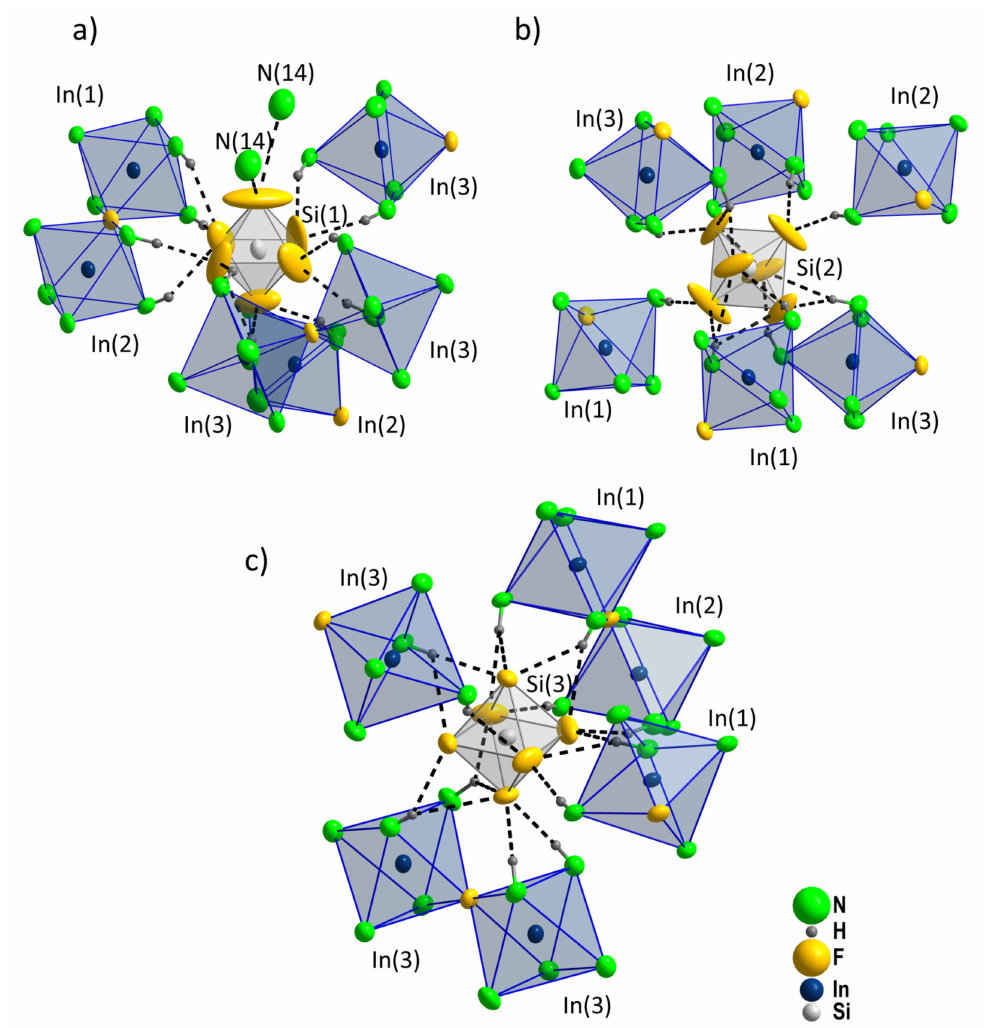
Figure 10. Interconnection of [SiF 6 ] 2 − octahedra to [(NH 3 ) 5 In − F − In(NH 3 ) 5 ] 5+ octahedra doubles via hydrogen bonds for ( a ) [Si(1)F 6 ] 2 − , ( b ) [Si(2)F 6 ] 2 − , and ( c ) [Si(3)F 6 ] 2 −